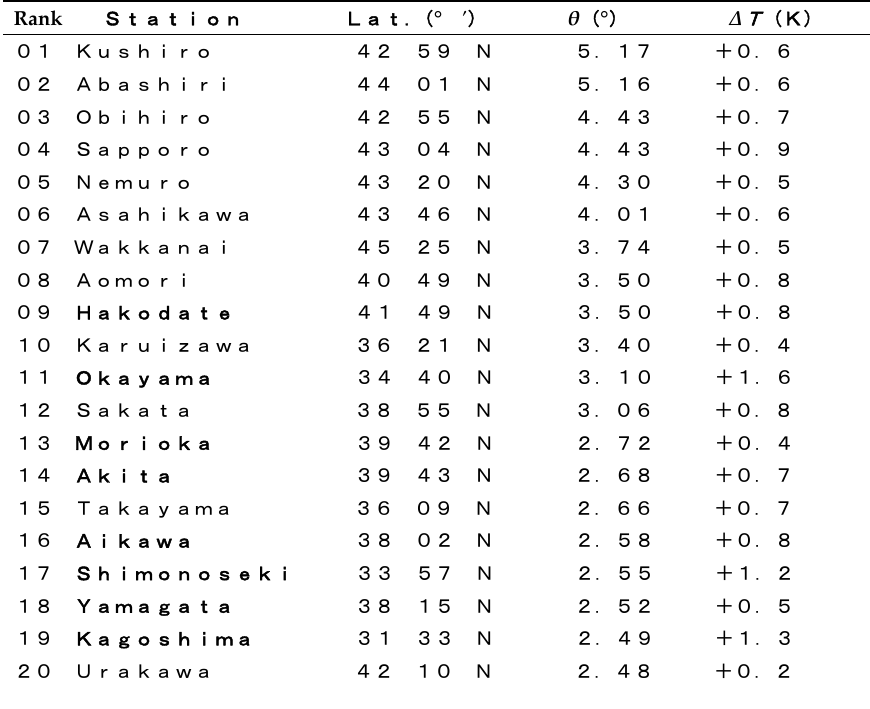
Table 6. Top-twenty Japanese stations in the rotation angle of the monthly distributions of temperatures from Period II (1951–1980) to III (1981–2010).